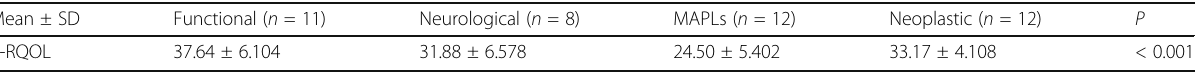
Table 8 Relation of V-RQOL scores for the elderly with different voice disorders